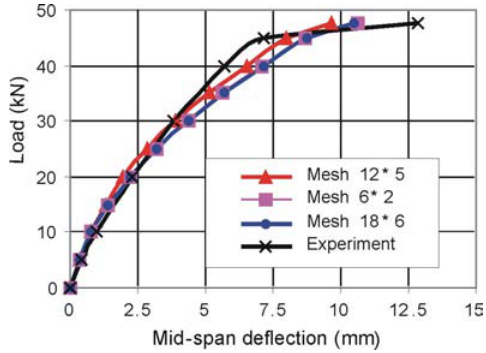
Fig. 8. Mesh size effect on the global response Fig. 9. Effect of bond models